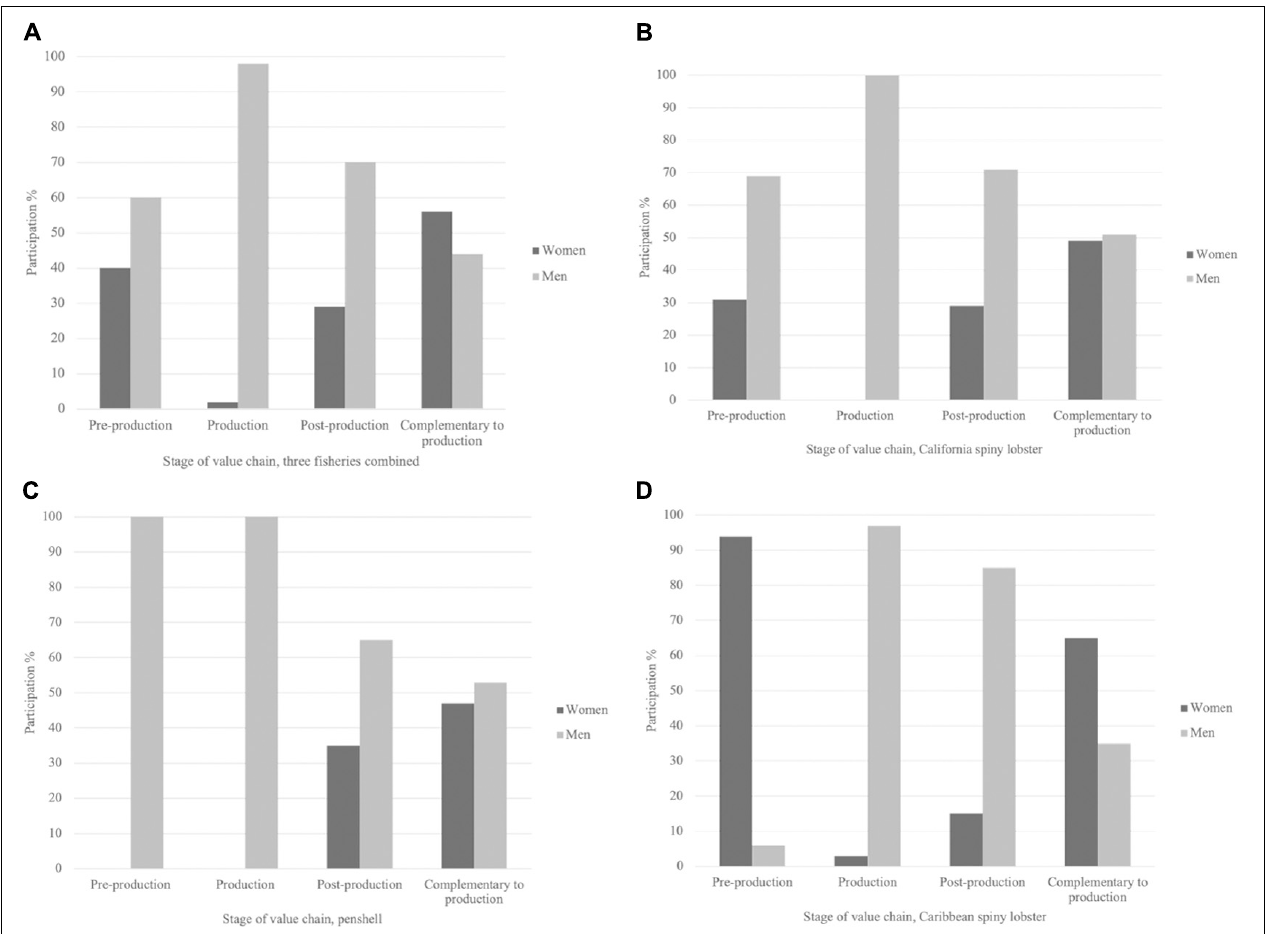
FIGURE 3 | Participation in value chain, with the three fisheries combined (A) , and specific to California spiny lobster (B) , penshell (C) , Caribbean spiny lobster (D)